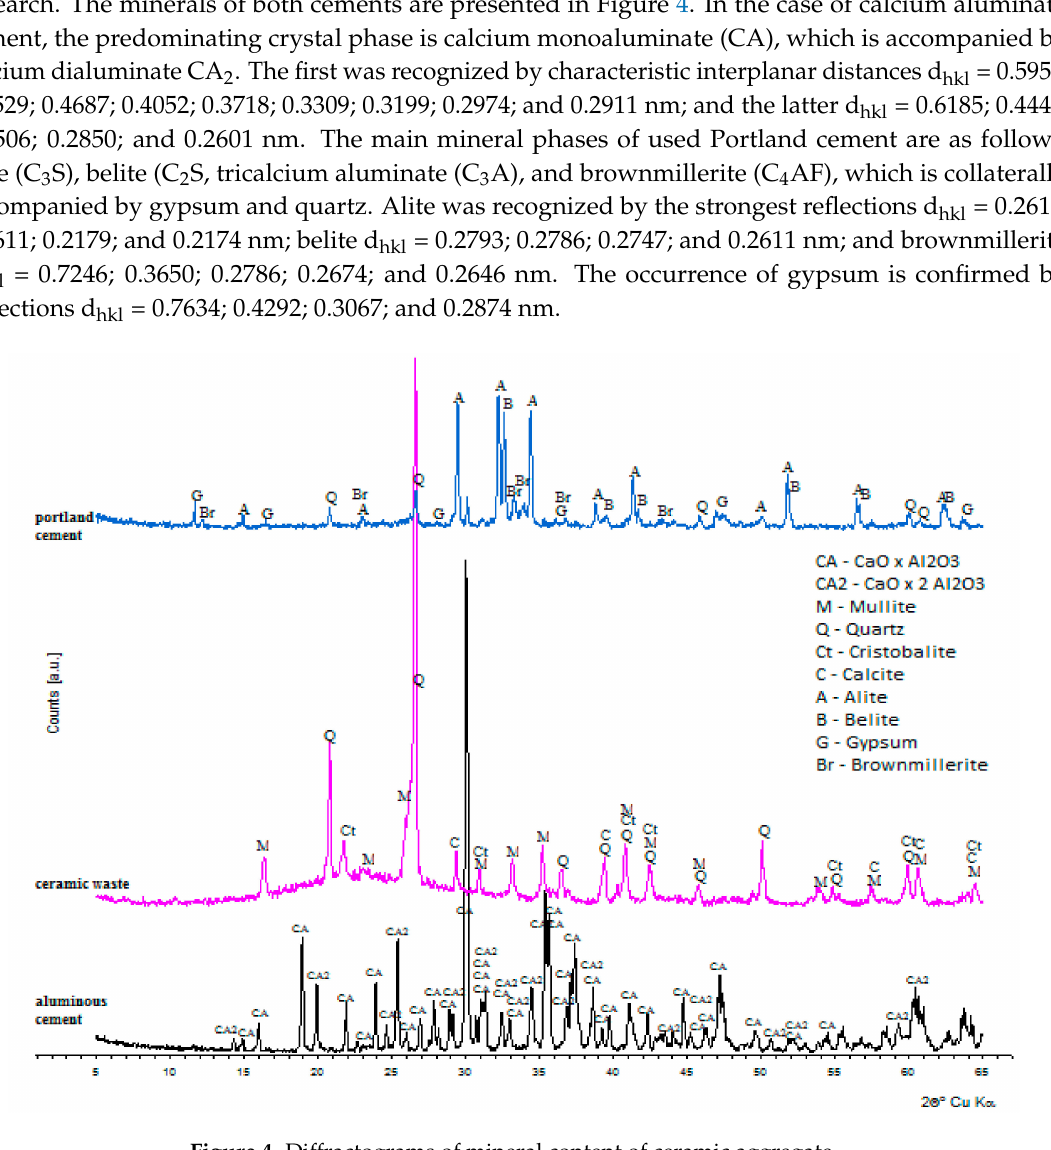
Figure 4. Diffractograms of mineral content of ceramic